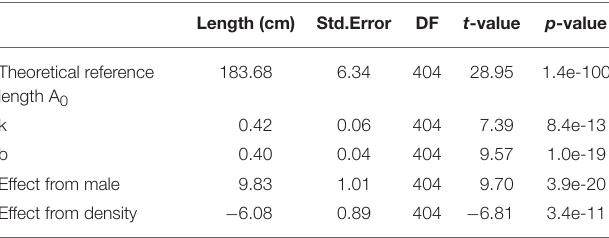
TABLE 3 | Fixed effects from Analysis 2 for the Skagerrak only, testing for density